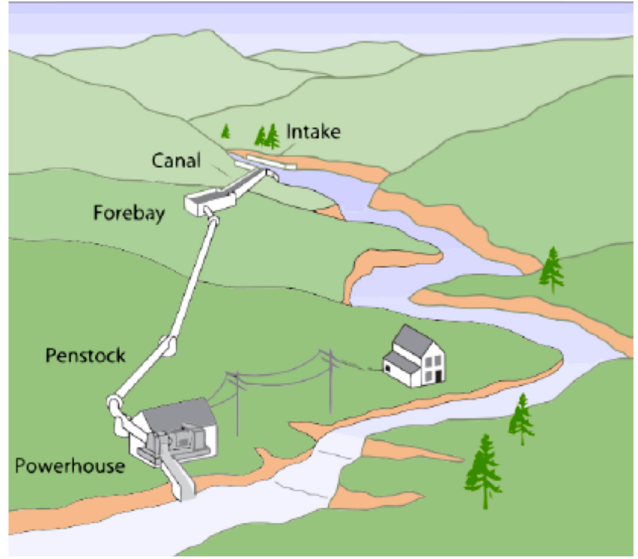
Figure 7. Schematic outline of a typical diversion type run-of-river small hydropower plant that can be connected to a mini-grid system. Source: [49,50]. connected to a mini-grid system. Source: